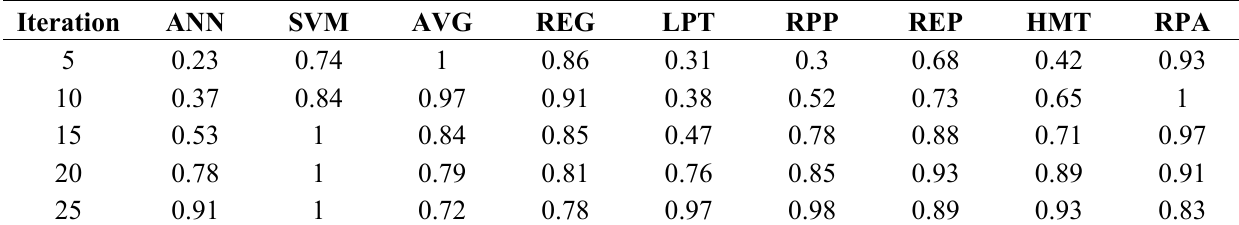
Table 1. Q values of each scenario throughout 25 iterations.